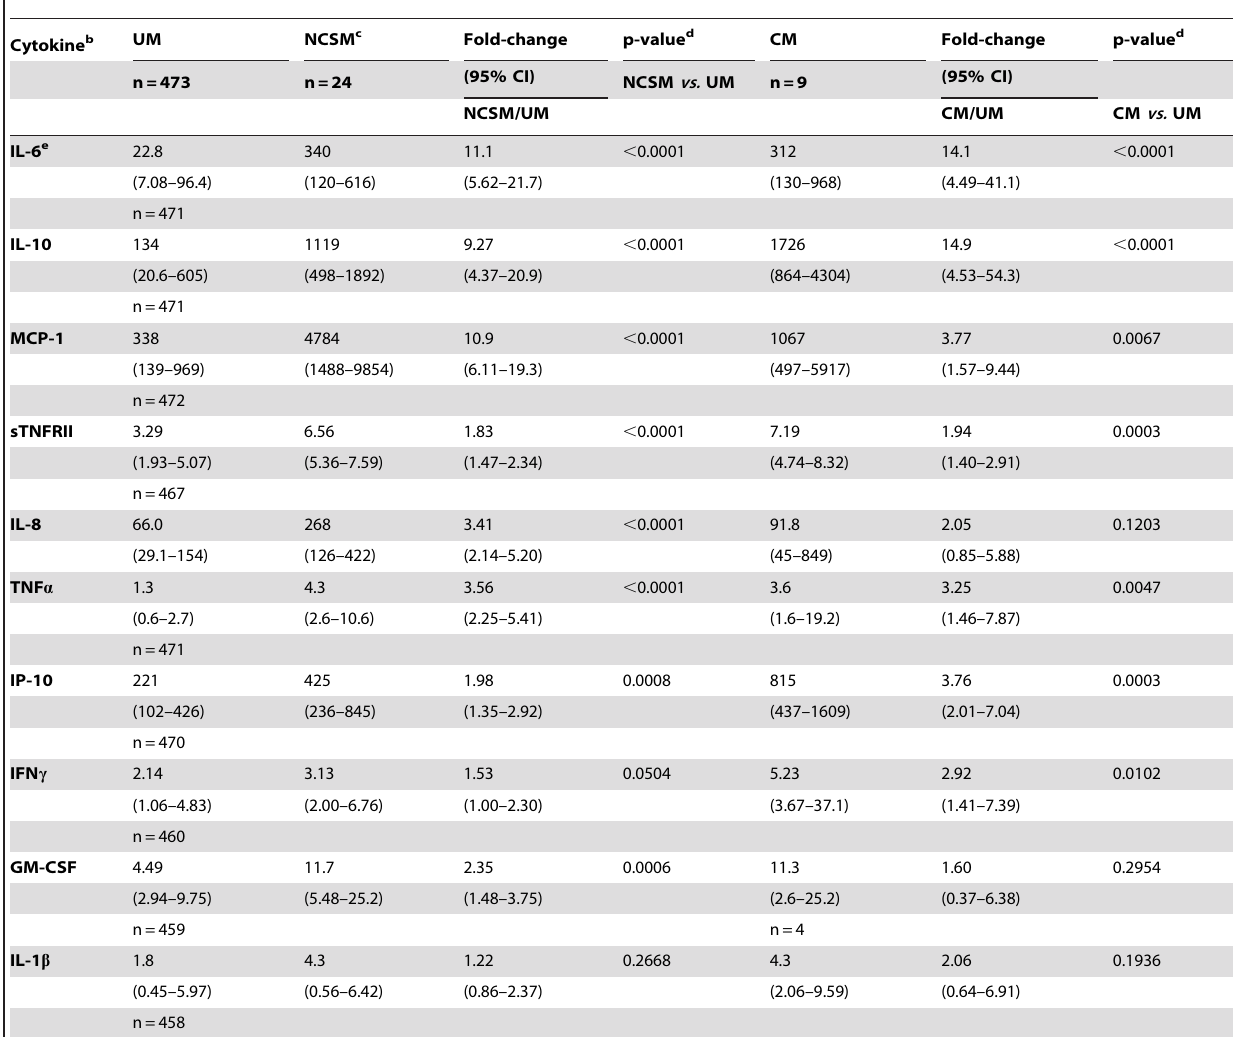
Table 2. Cytokine levels, stratified by clinical presentation.